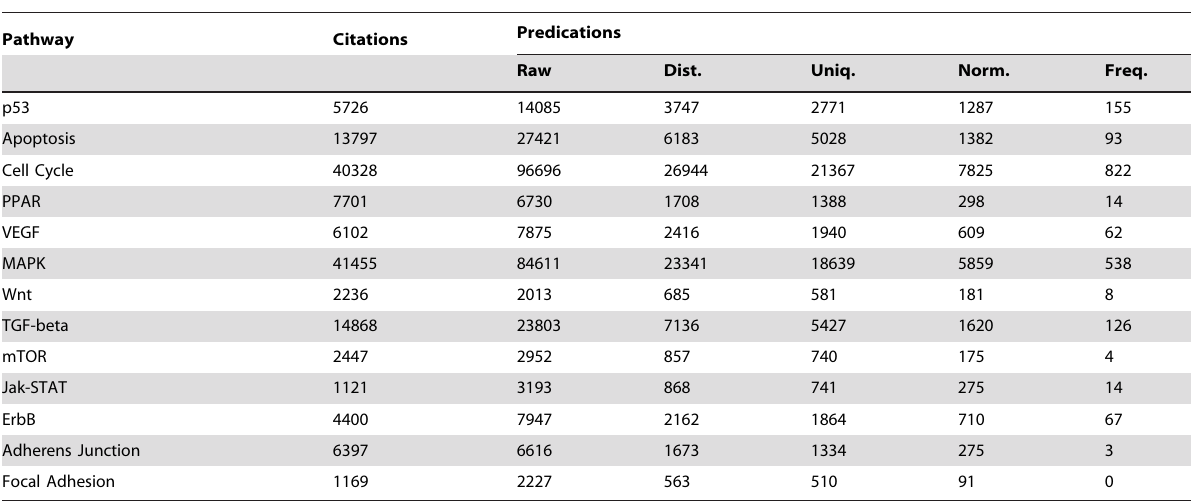
Table 1. Number of predications for each pathway.